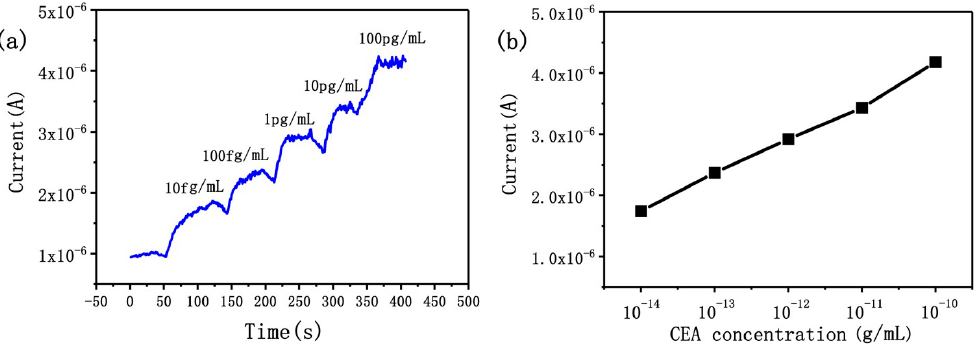
Figure 5. ( a ) The sensor response to different serum CEA concentrations. ( b ) The current signal versus exponential increases of serum CEA concentration.